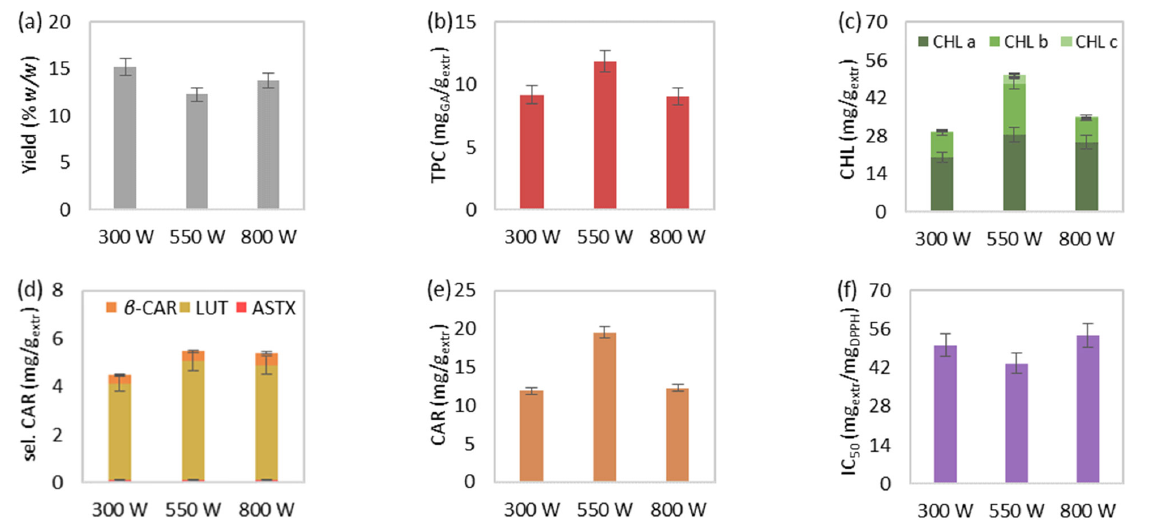
Figure 3. The effect of extraction temperature on MAE’s ( a ) extraction yield, extract’s total ( b ) phenolic and ( c ) chlorophyll content, ( d ) selected and ( e ) total carotenoid content, and ( f ) antioxidant activity. The extraction conditions of the single-factor experiments were maintained at 55 mL solv /g biom , 15 min and 550 watts.